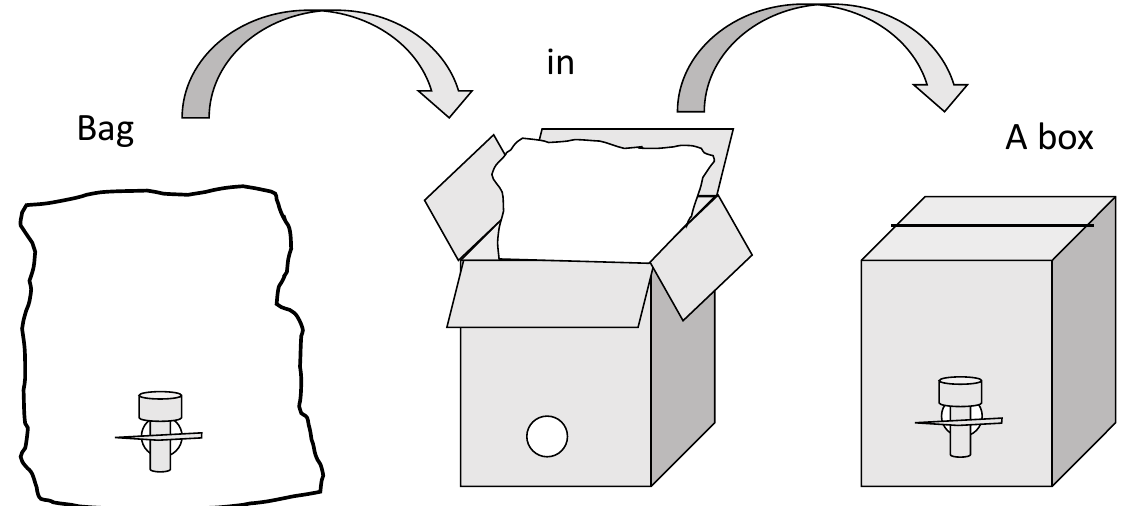
Figure 1. A schematic of a bag-in-box (BIB) design used by the packaging industry.